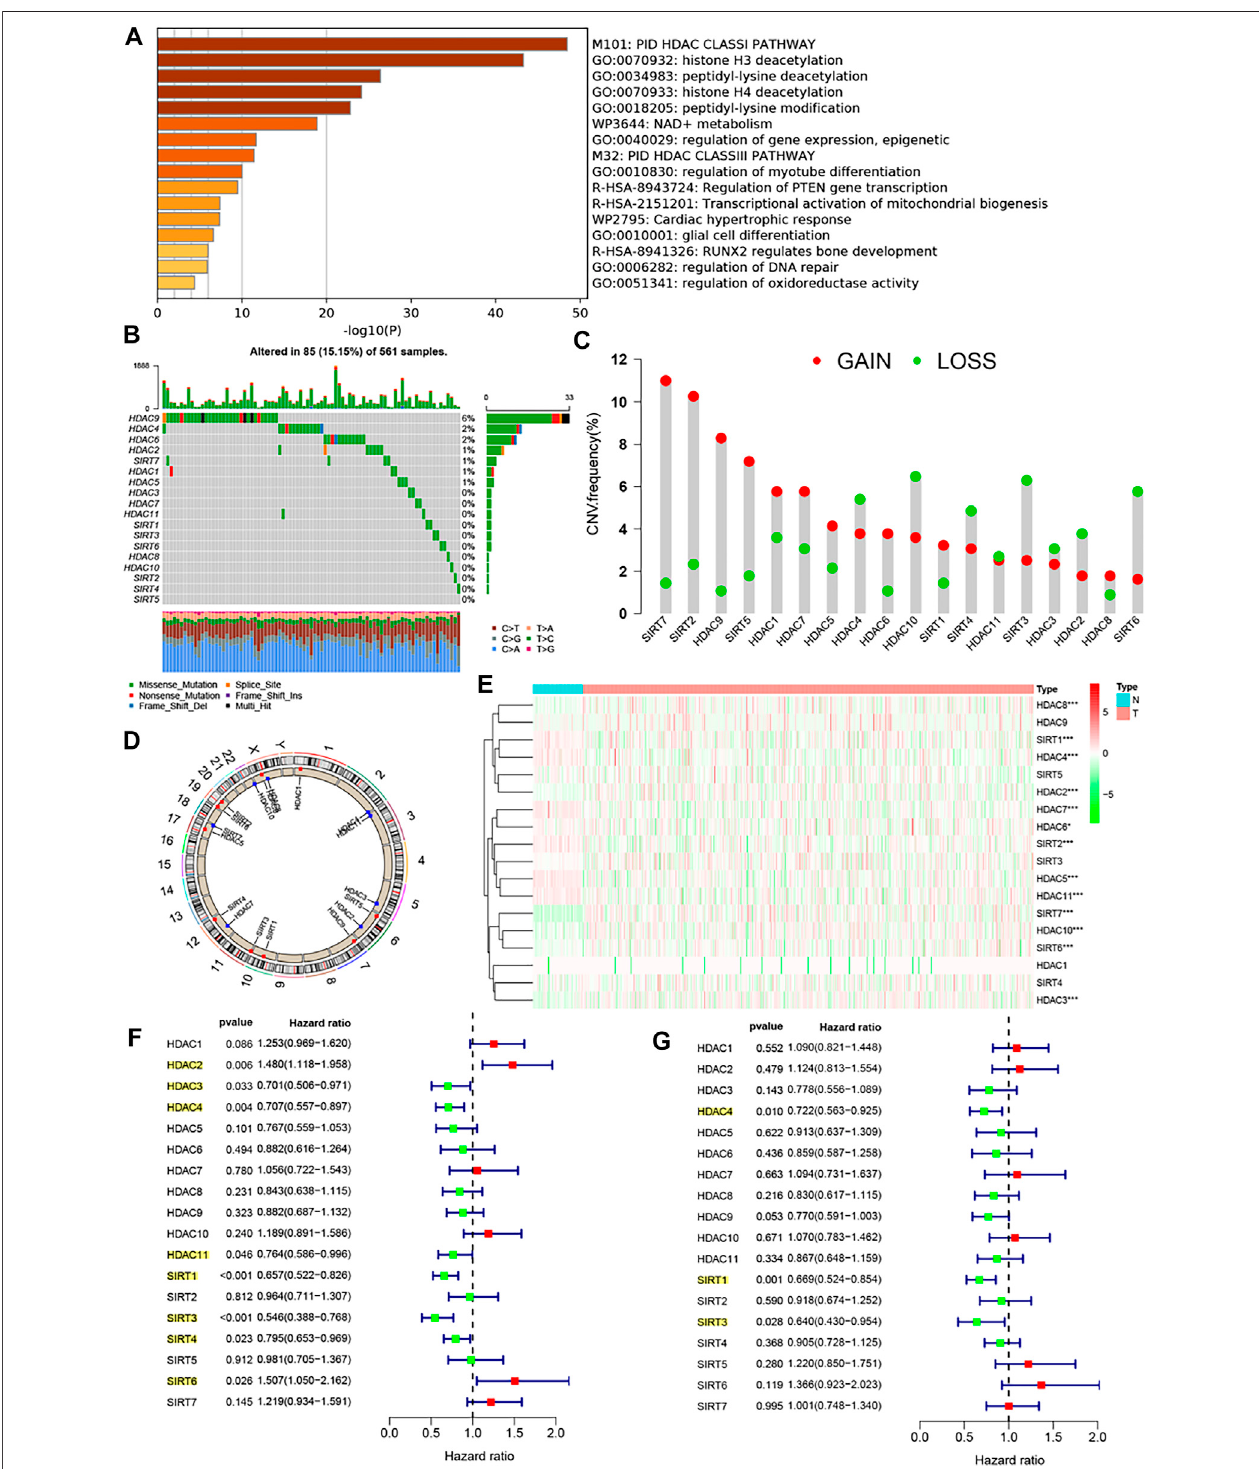
FIGURE 1 | Biological characterization of the HDAC family genes. (A) Metascape analysis revealed the biological function of the 18 HDAC family genes. (B) Mutation frequency of 18 HDAC family genes in 561 LUAD patients from the TCGA − LUAD cohort. Each column represented individual patients. The upper barplot showedTMB,andthenumberontherightindicatedthemutationfrequencyineachregulator.Therightbarplotshowedtheproportionofeachvarianttype.Thestacked